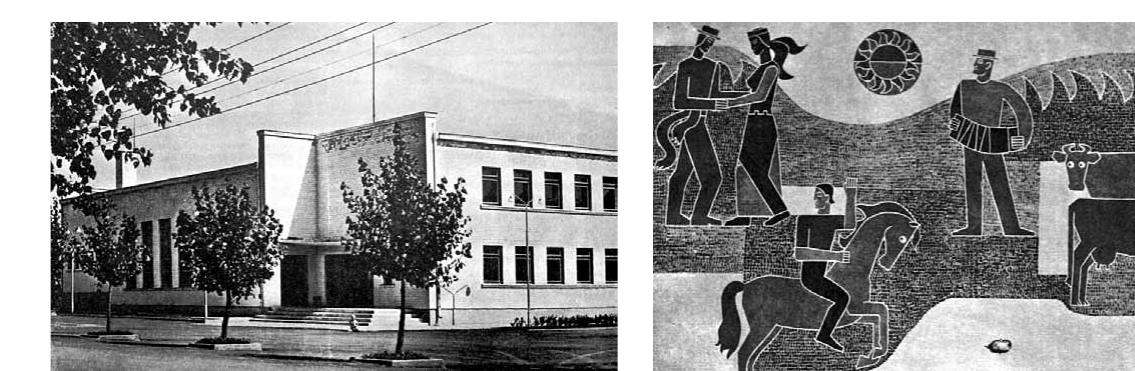
Fig. 6. The decorative pano of House of Culture in Duokiškis (rokiškis region), artist V. Gurskis, 1974